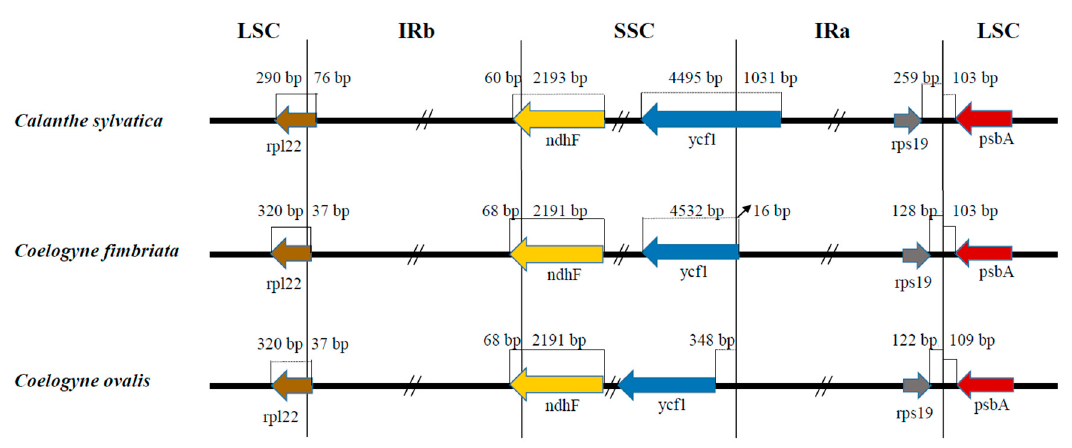
Figure 4. Borders comparison of the LSC, SSC, and IRs regions of two Coelogyne species with C. sylvatica as a reference. LSC: large single-copy region; SSC: small single-copy region; IRa: inverted repeat region A; IRb: inverted repeat region B.